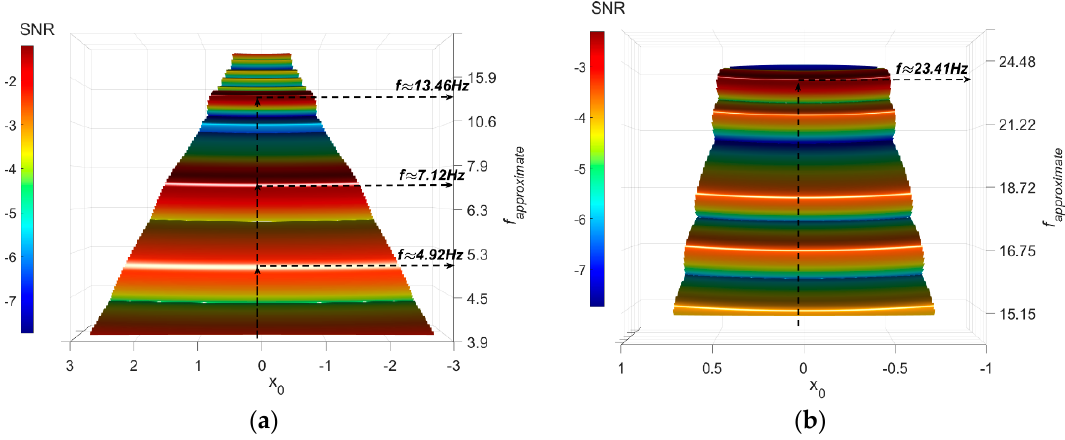
Figure 11. SNR-surface plots for the vehicle acceleration ( a ) [4 Hz–25 Hz]. ( b ) [15 Hz–25 Hz].